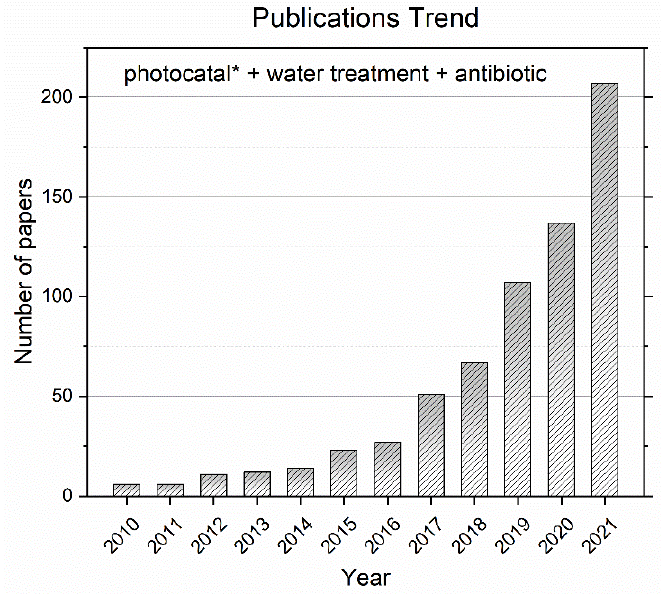
Figure 1. Publications trend: Web of Science results for the number of yearly publications on photocatalytic water treatment of antibiotics from 2010 to 2021.